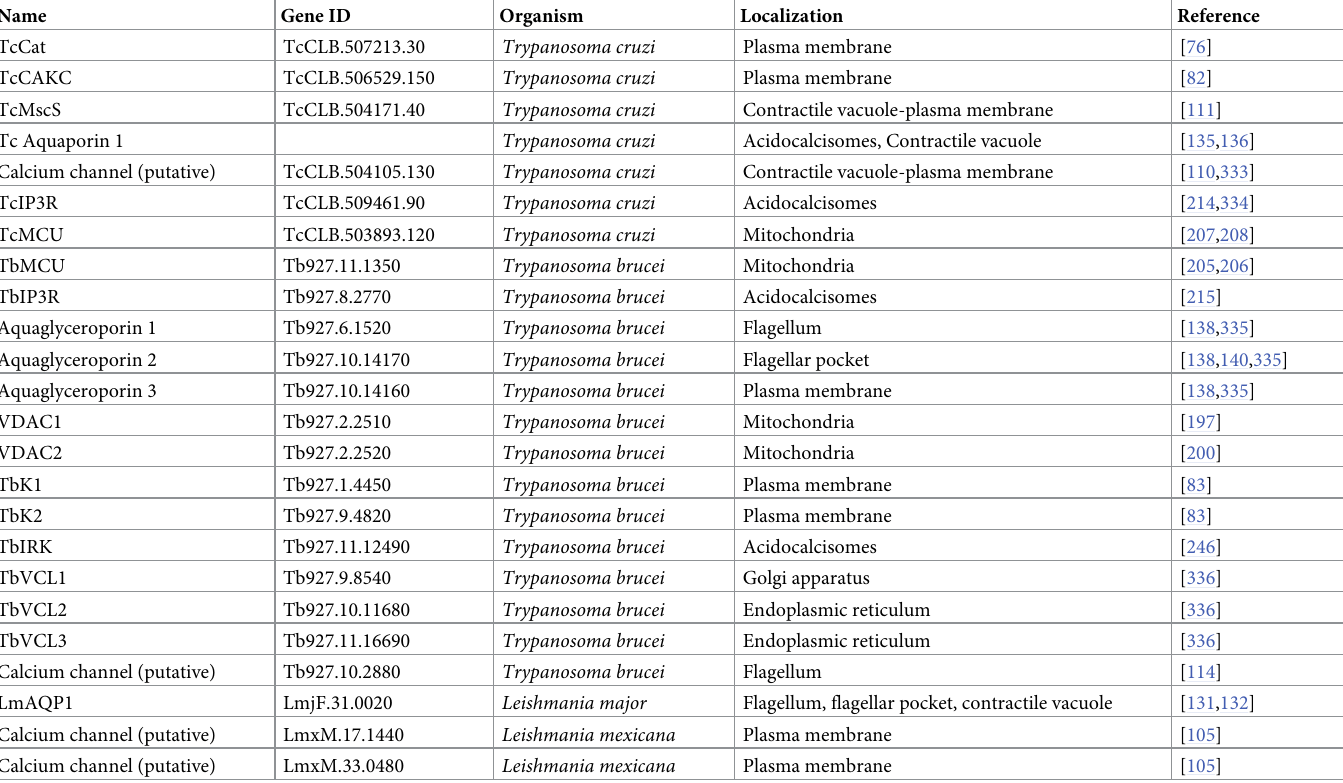
Table 1. Ion channels in pathogenic trypanosomatids.